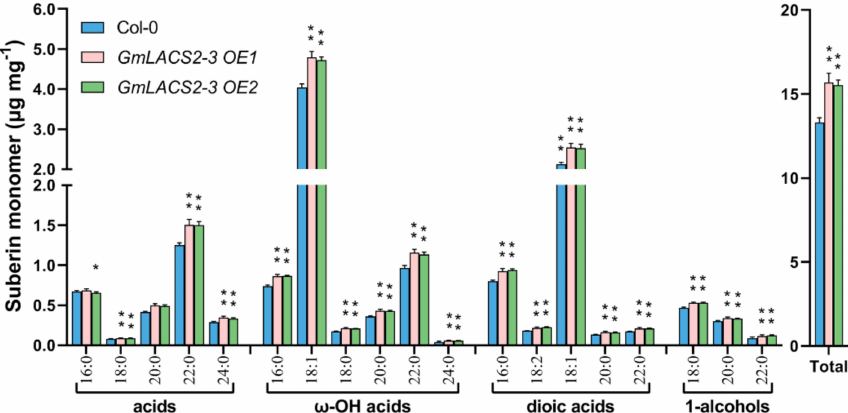
Figure 7. Suberin monomer composition in roots of the Arabidopsis wild-type Col-0, GmLACS2-3 OE1 , and GmLACS2-3 OE2 . The values shown are means ± SD ( n = 4). * and ** respectively indicate significant difference ( p < 0.05) and highly significant difference ( p < 0.01).